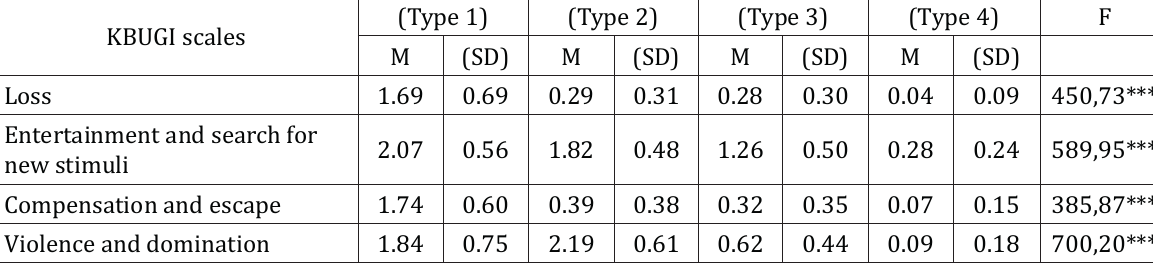
Table 1. Mean scores obtained by the four groups (types) of gamers on the KBUGI scales